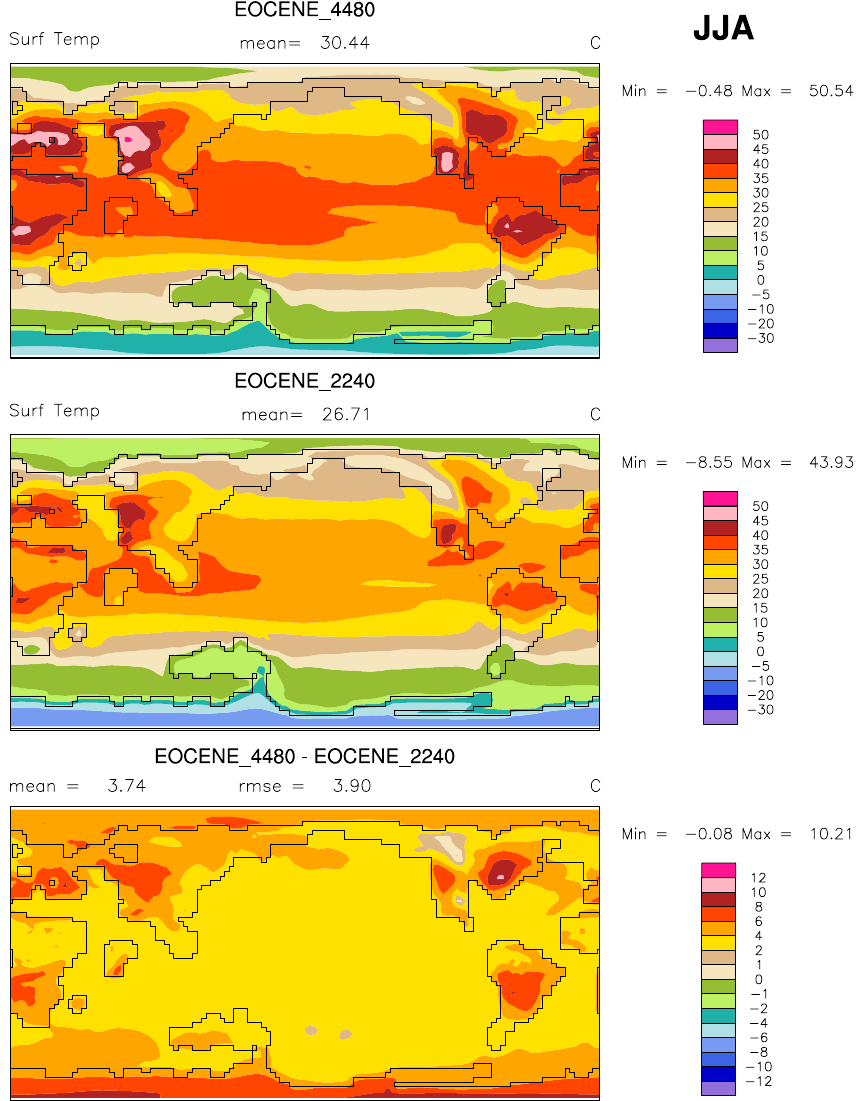
Fig. 3c. Figure 3 continued, see Fig. 3a for